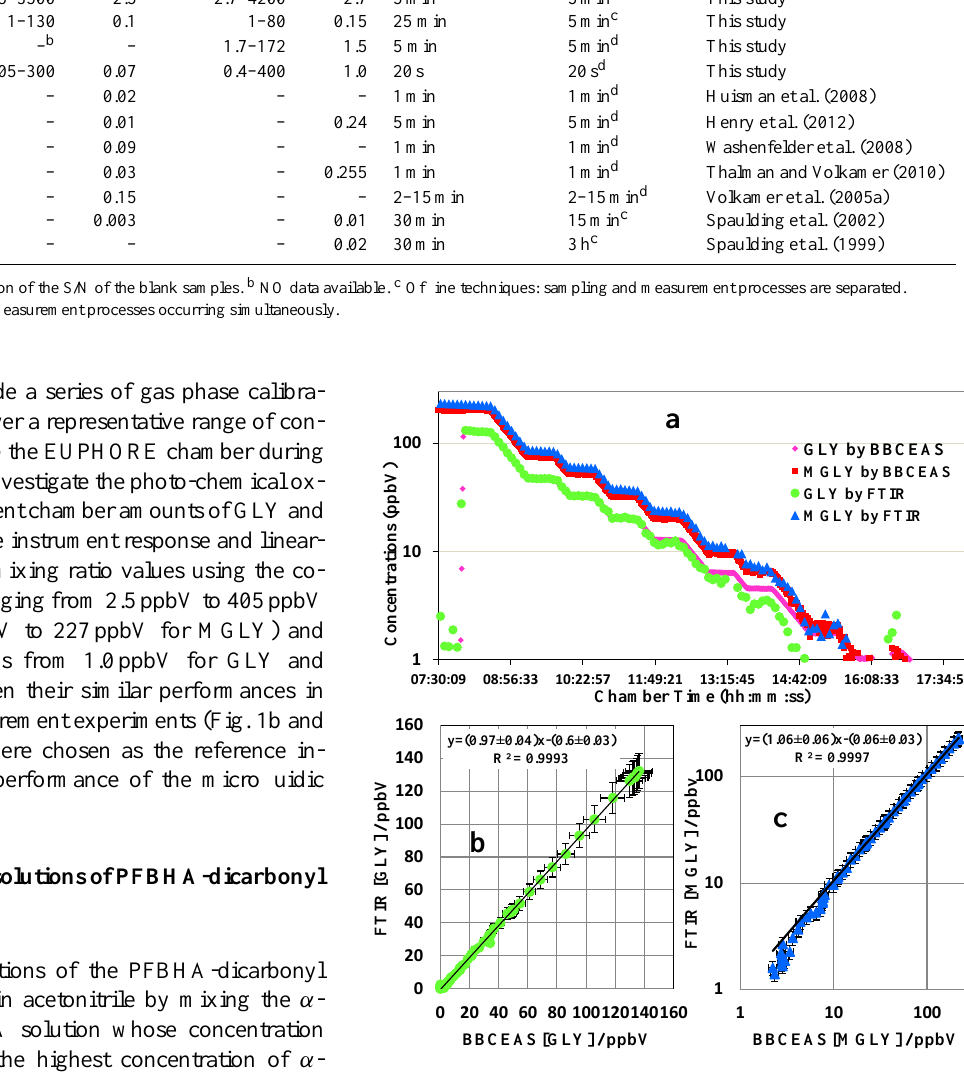
Fig. 1. Comparison between FTIR and BBCEAS measurements of GLY and MGLY. (a) : Comparison between FTIR and BBCEAS measurements during the preparation of standard gaseous GLY and MGLY mixture in the EUPHORE chamber; (b) : linear relation- ship between FTIR and BBCEAS for GLY measurement (error bars indicate the accuracies of FTIR and BBCEAS on GLY mea- surement); (c) : linear relationship between FTIR and BBCEAS for MGLY measurement (error bars indicate the accuracies of FTIR and BBCEAS on MGLY measurement). The uncertainties of the slopes are less than